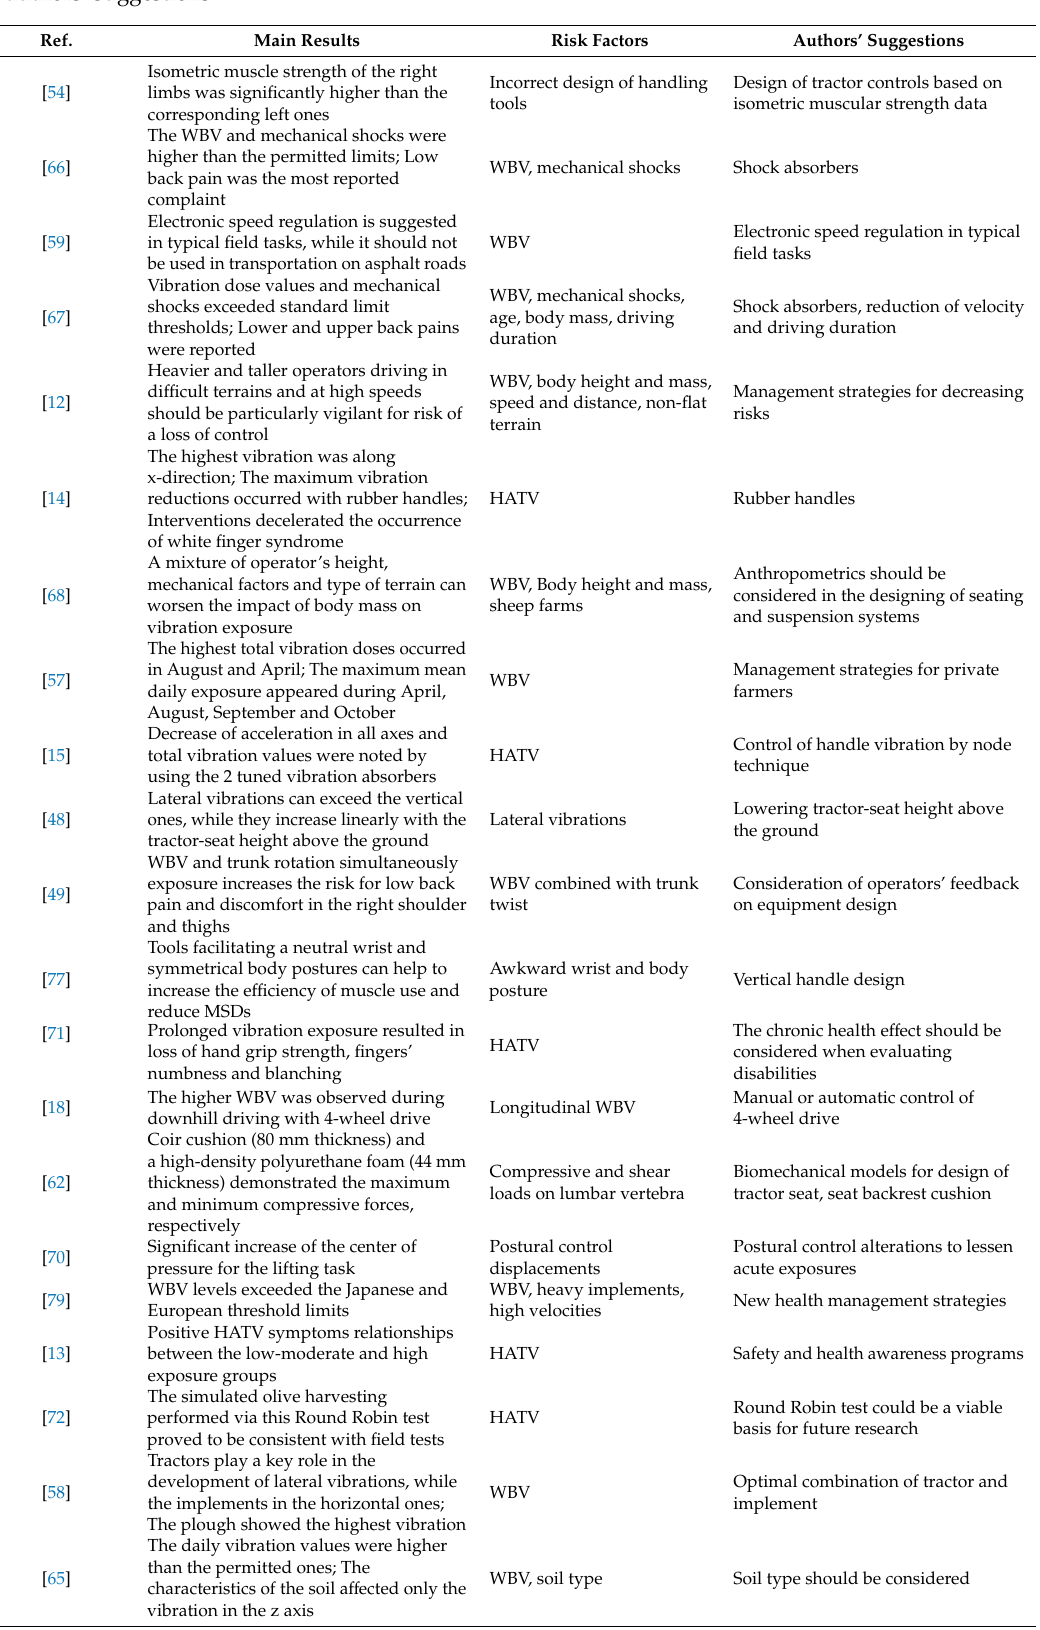
Table 3. List of the selected journal papers along with their main results, identified risk factors and authors’